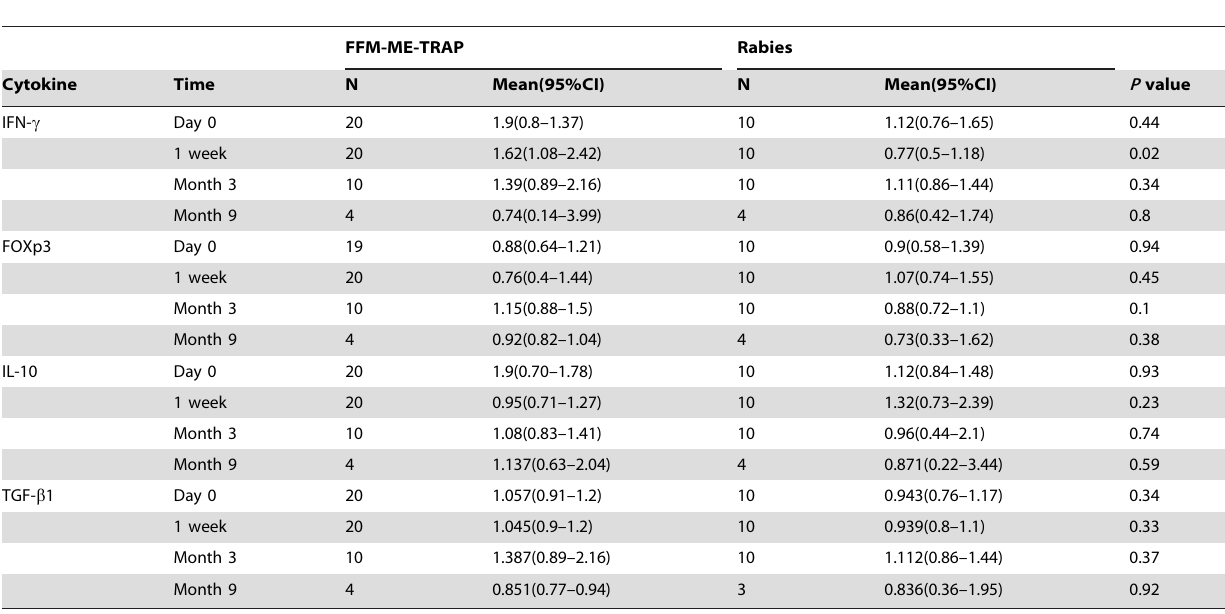
Table 2. Mean expression of the different cytokines/markers at different time points (log copy number/HPRT).